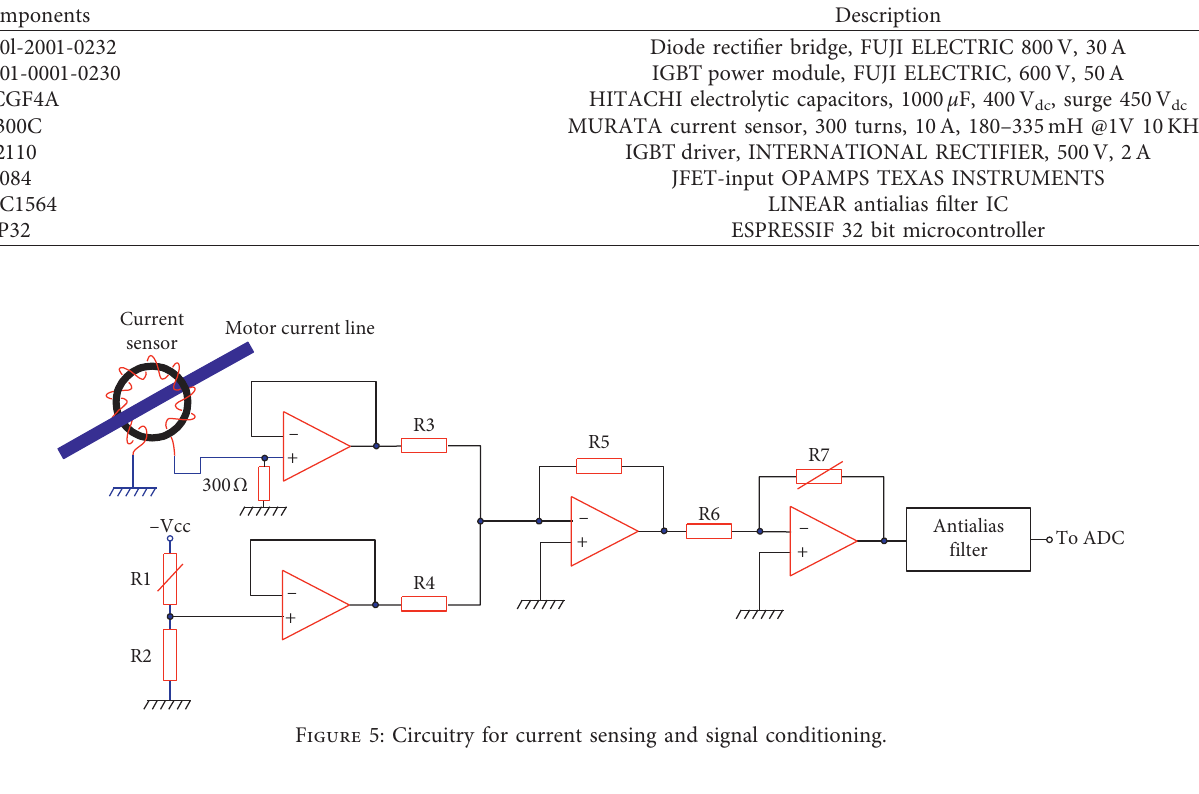
Figure 4: DTC servodrive prototype including (a) the three-phase rectifier bridge, (b) capacitor filters, (c) the IGBTpower module, (d) the inductive current sensors, (e) the IGBT gate drivers, (f) the signal conditioning modules, (g) the ESP32 microcontroller, and (h) the DC power supply for low-power integrated Table 2: Main electronic components used in the DTC servodrive.